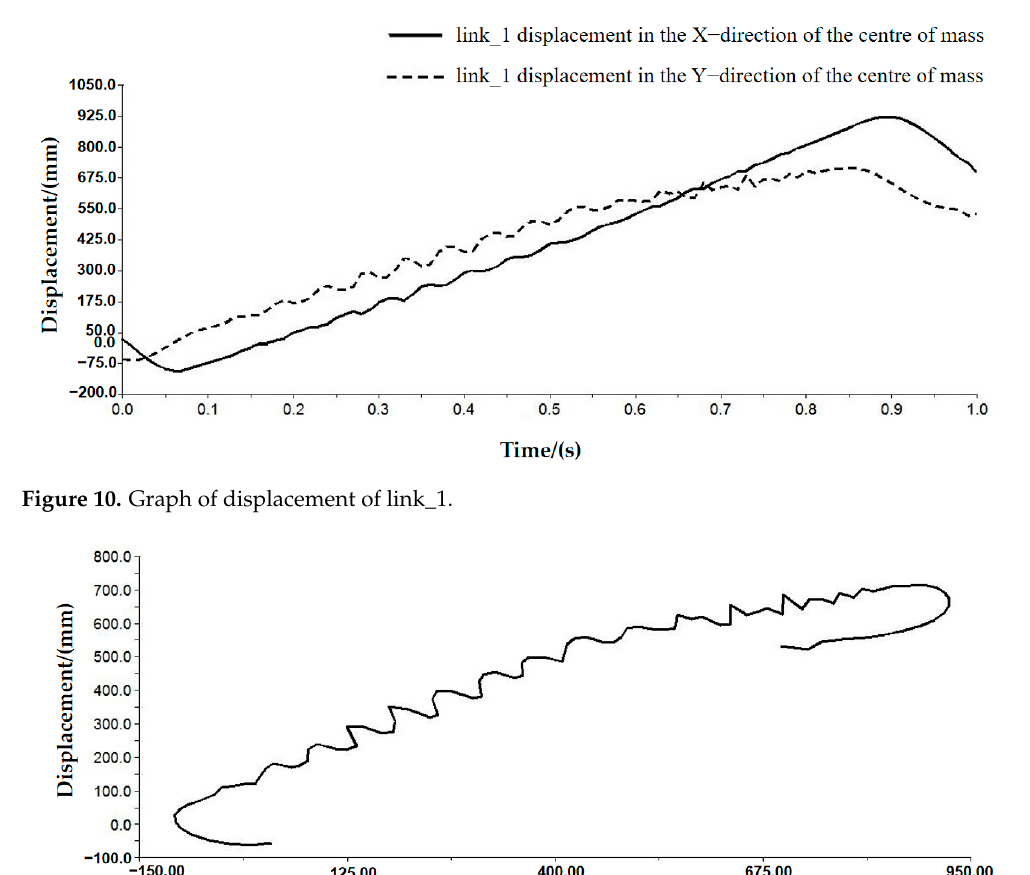
Figure 11. Trajectory curve of link_1.